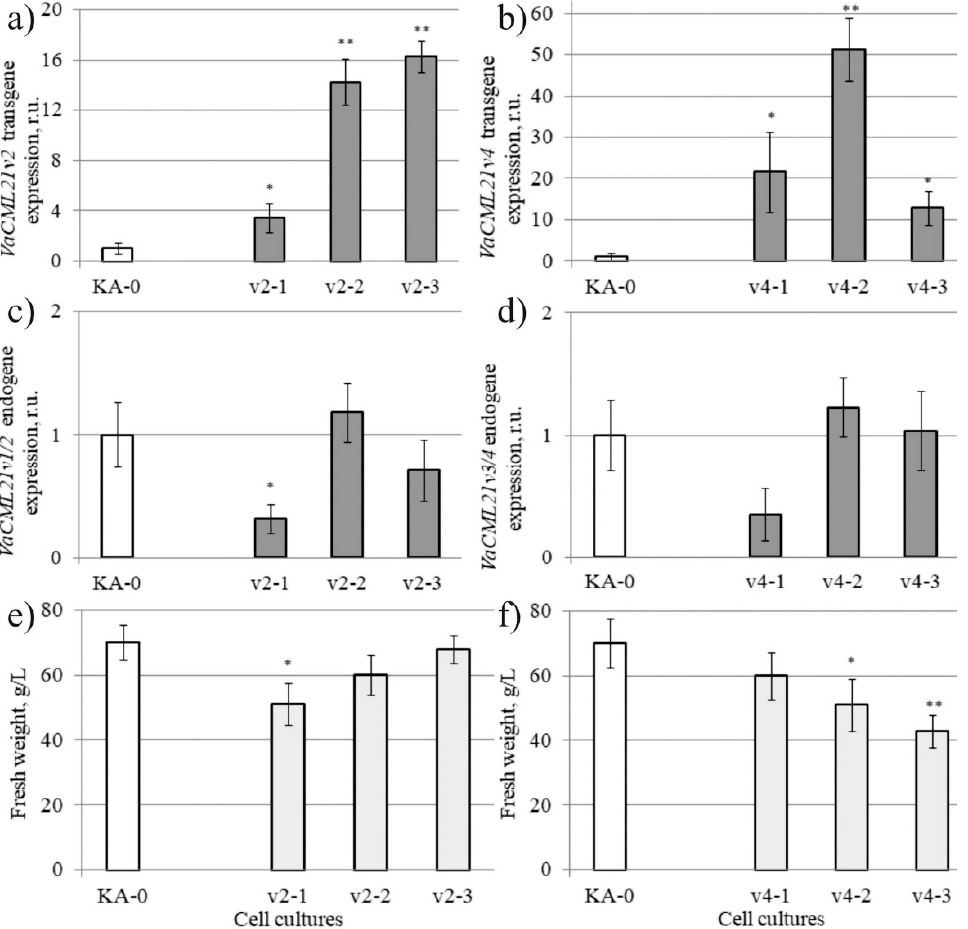
Figure 4. Characterization of the grapevine callus cell cultures transformed with the VaCML21v2 and VaCMLv4 splice variants. ( a , b ) Quantification of the VaCML21v2 and VaCML21v4 transgene mRNAs; ( c , d ) Quantification of the endogenous VaCML21v1/v2 and VaCML21v3/v4 mRNAs. ( e,f ) Fresh biomass accumulation in the VaCML21v2 -transgenic and VaCML21v4 -transgenic cell cultures after 30-day cultivation. v2-1, v2-2, v2-3— VaCML21v2 -transformed calli; v4-1, v4-2, v4-3— VaCML21v4 -transformed calli. KA-0—control cell culture transformed with the “empty” vector. The data are presented as the mean ± SE (two independent experiments). * p ≤ 0.05; ** p ≤ 0.01 versus values of VaCML21